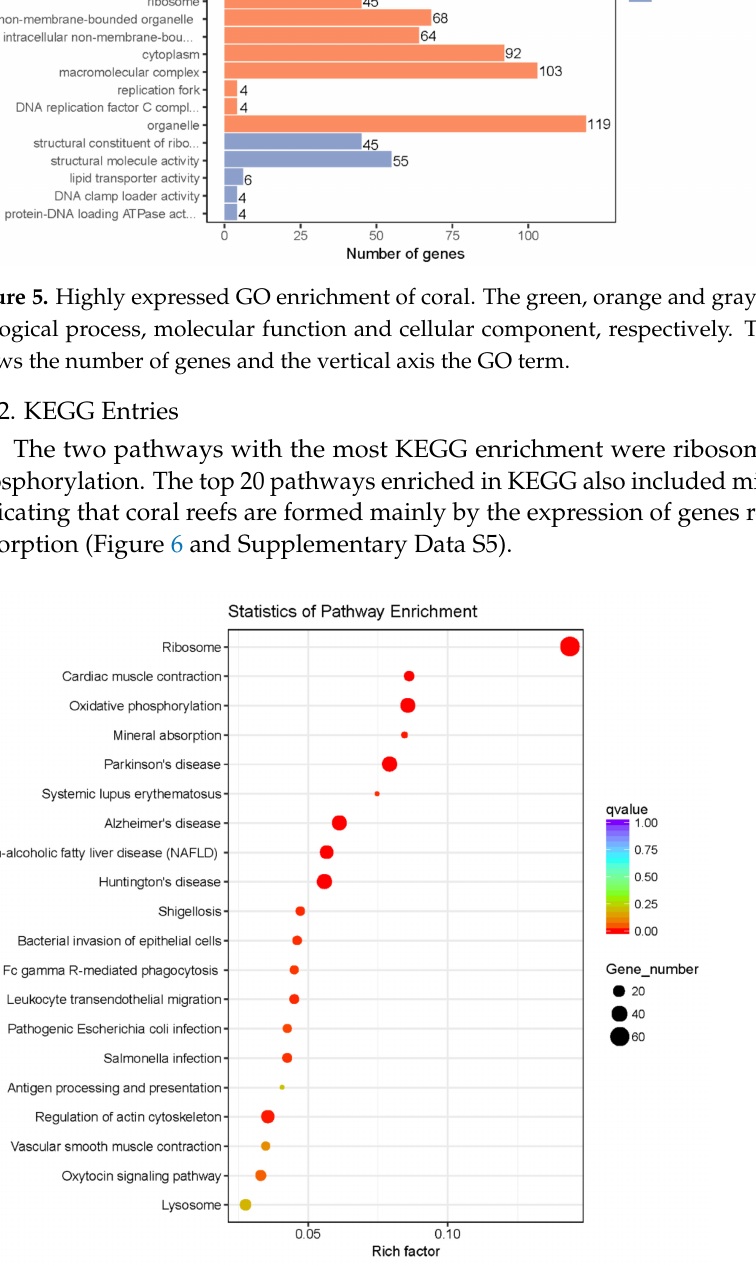
Figure 6. Highly expressed gene KEGG scatter plot of coral. The horizontal axis represents the rich factor and the vertical axis the KEGG term. The circle size represents the number of genes, and the color from purple to red indicates a q-value from 1 to